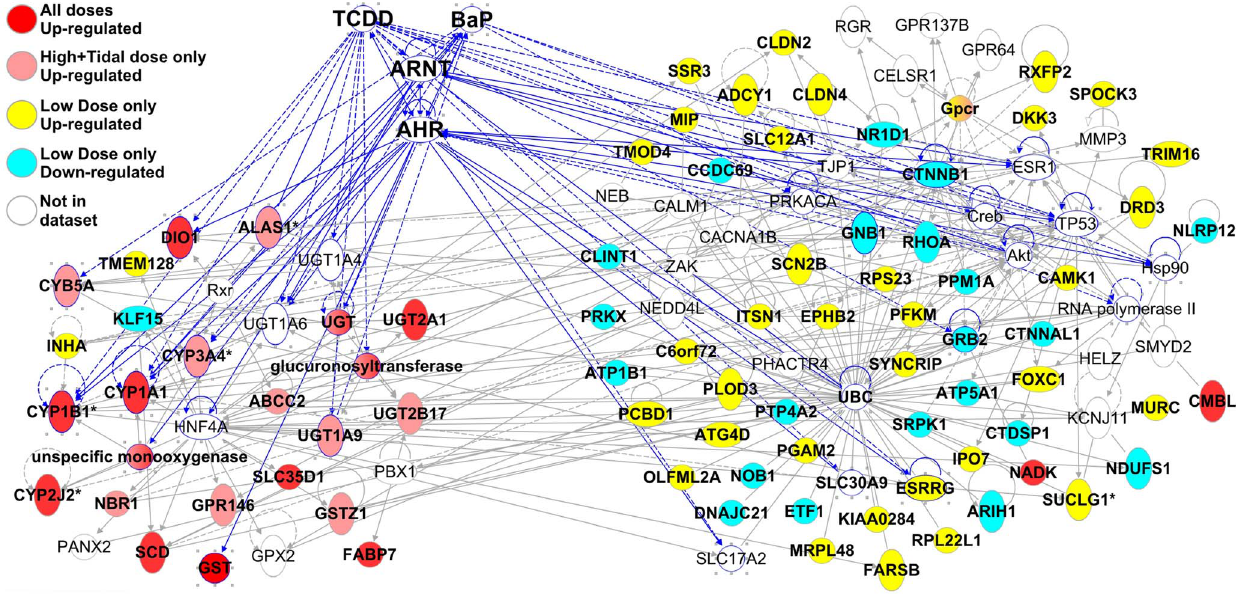
Figure 5. Liver gene interaction network connected by aryl hydrocarbon receptor (AHR) and aryl hydrocarbon receptor nuclear translocator (ARNT) hubs and model toxicants benzo-a-pyrene (BaP) and 2,3,7,8-tetrachlorodibenzo- p -dioxin (TCDD). Genes up- regulated at high concentrations (Fig. 2 cluster 1) are colored red, genes that are up- and down-regulated in the low concentration only are colored yellow and blue, respectively. Lines represent interactions between genes, and blue lines highlight genes that directly interact with AHR/ARNT/TCDD/ BAP.